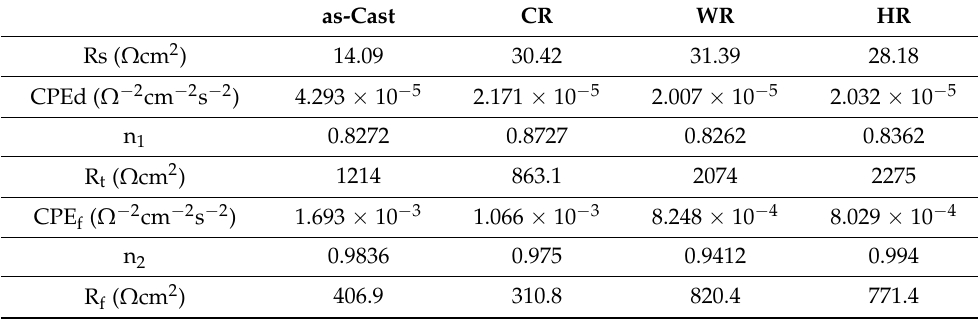
Table 4. The fitted electrochemical parameters for WE43 alloys in Hank’s solution.